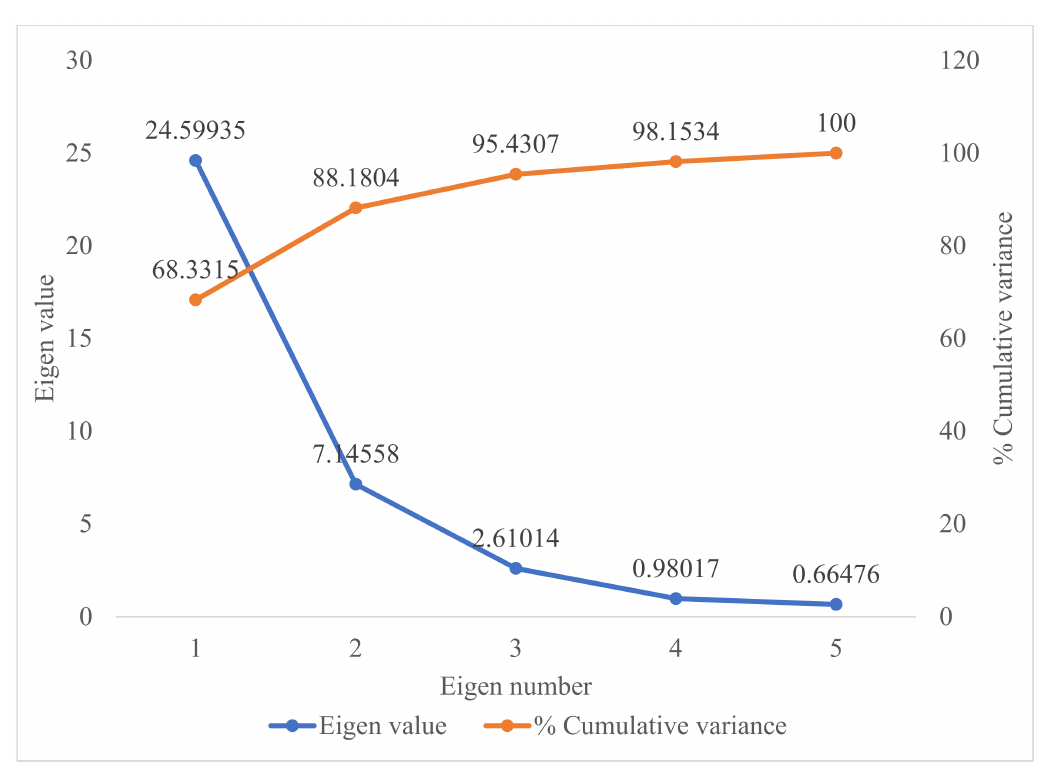
Figure 6. Scree plot of the principal components for raw white rice, cowpea, sorghum leaves, their composite blend, and cooked products, showing Eigen values and contribution to total variance. Table 5. Percentage contribution of each sample to the principal components for the principal component analysis. Raw Raw Sample Rice